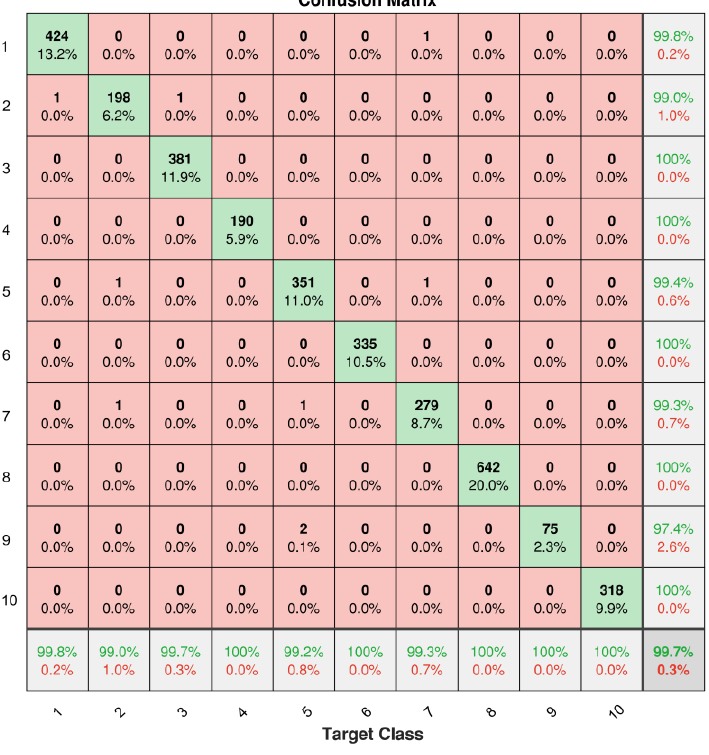
Figure 9. Classification evaluation results of nine leaf diseases and one healthy leaf: ( 1 ) Bacterial spot disease, ( 2 ) Early blight disease, ( 3 ) Late blight disease, ( 4 ) Leaf mold disease, ( 5 ) Septoria leaf spot disease, ( 6 ) Two-spotted spider mites, ( 7 ) Target spot disease, ( 8 ) Yellow leaf curl virus disease, ( 9 ) Mosaic virus disease, ( 10 ) Healthy leaf.